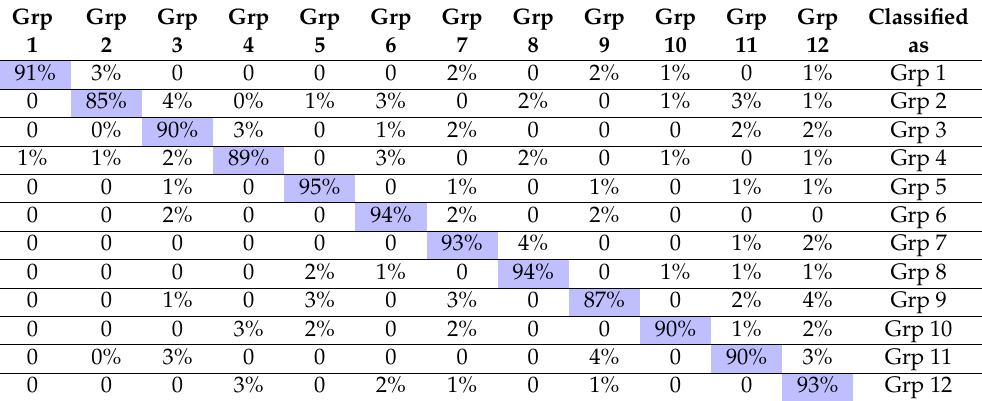
Confusion matrix of n -fold cross-validation (8-fold) results for Urdu handwritten numeral